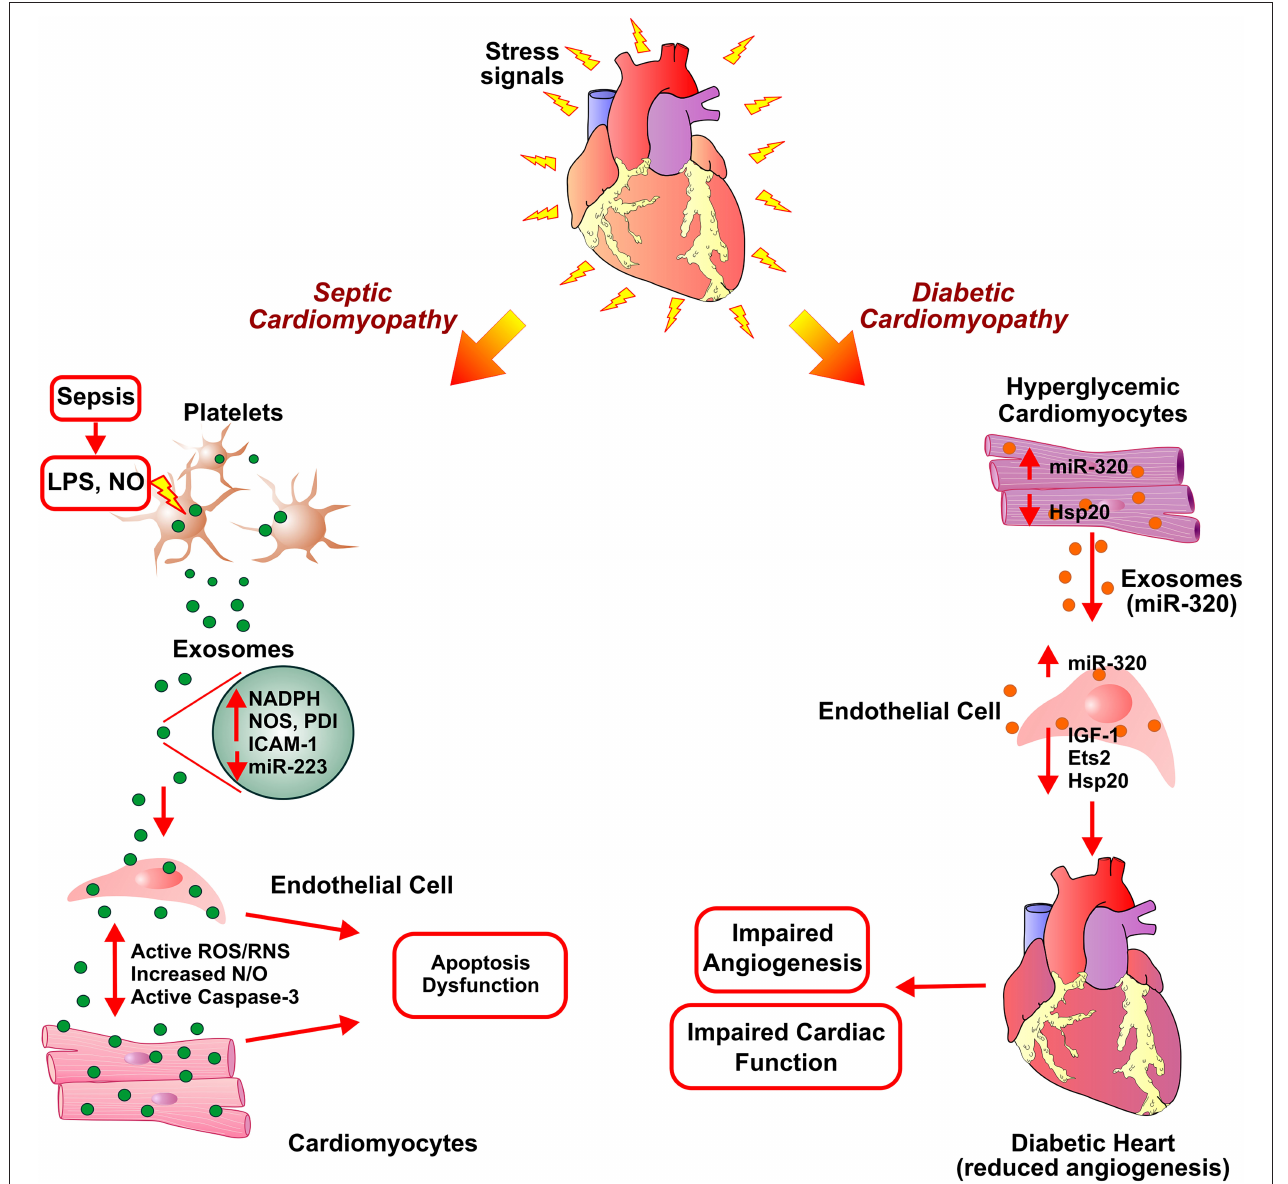
FIGURE 3 | Exosome-assisted development of septic cardiomyopathy and diabetic hypertrophy. In response to high levels of lipopolysaccharide (LPS) and nitric oxide (NO) in sepsis, platelets secrete inflammatory exosomes with reduced miR-233 and are enriched in NADPH oxidase, nitric oxide synthases (NOS), and protein disulfide isomerase (PDI). This induces apoptosis in endothelial cells and cardiomyocytes via activation of reactive oxygen/ nitrogen species (ROS/RNS) signaling pathways, caspase 3 activation, thereby leading to cardiomyopathy. Exosomes secreted from diabetic cardiomyocytes contain increased levels of miR-320. Uptake of exosomal miR-320 by endothelial cells results in increased levels of Hsp20, IGF-1, and Ets2, thus, inhibiting angiogenesis in diabetic